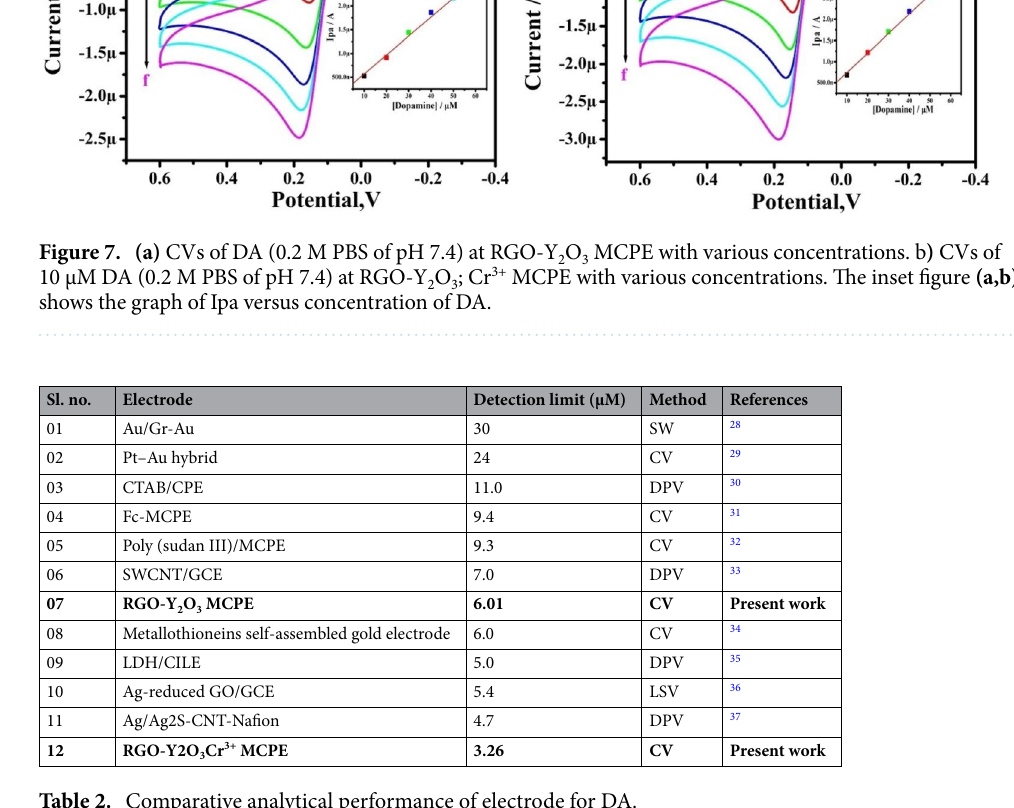
Table 2. Comparative analytical performance of electrode for DA.